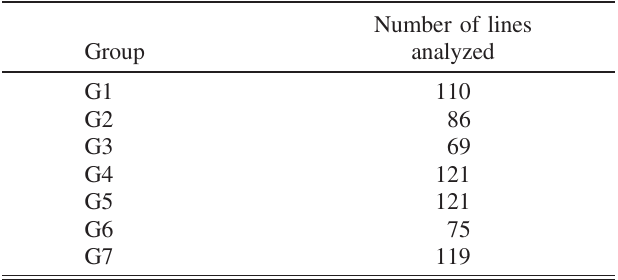
TABLE III. The numbers of lines analyzed for each group.